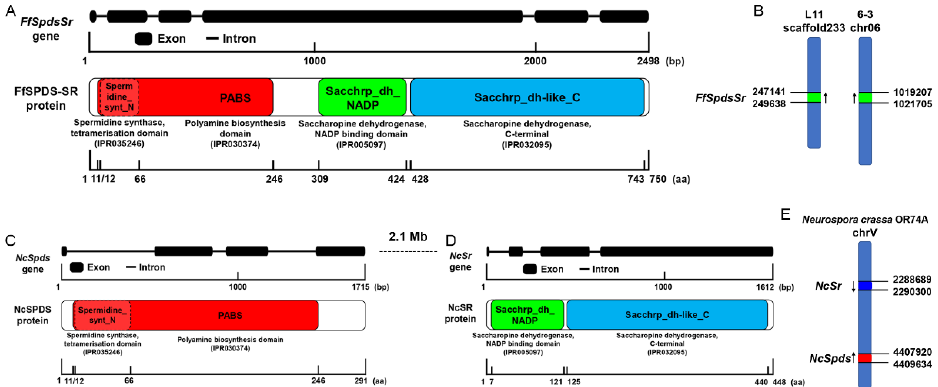
Figure 1. Gene structures and protein conserved domains of FfSpdsSr in Flammulina filiformis and NcSpds and NcSr in Neurospora crassa . ( A ) Gene structures and protein conserved domains of FfSpdsSr in F. filiformis . Thick lines represent exons and thin lines represent introns. ( B ) The location of the FfSpdsSr gene in the genome of F. filiformis strains L11 and 6-3. The green rectangles represent the region of the FfSpdsSr gene on the chromosome . The black arrows indicate the ORF direction of the FfSpdsSr gene. ( C ) Gene structures and protein conserved domains of NcSpds in N. crassa . Thick lines represent exons and thin lines represent introns. ( D ) Gene structures and protein conserved domains of NcSr in N. crassa . Thick lines represent exons and thin lines represent introns. ( E ) The blue rectangle and red rectangle represent the region of NcSr and NcSpds genes on the chromosome in N. crassa , respectively. The black arrows represent the ORF direction of NcSpds and NcSr genes. the local BLAST in the whole genome of F. filiformis strain L11 using the conserved domain